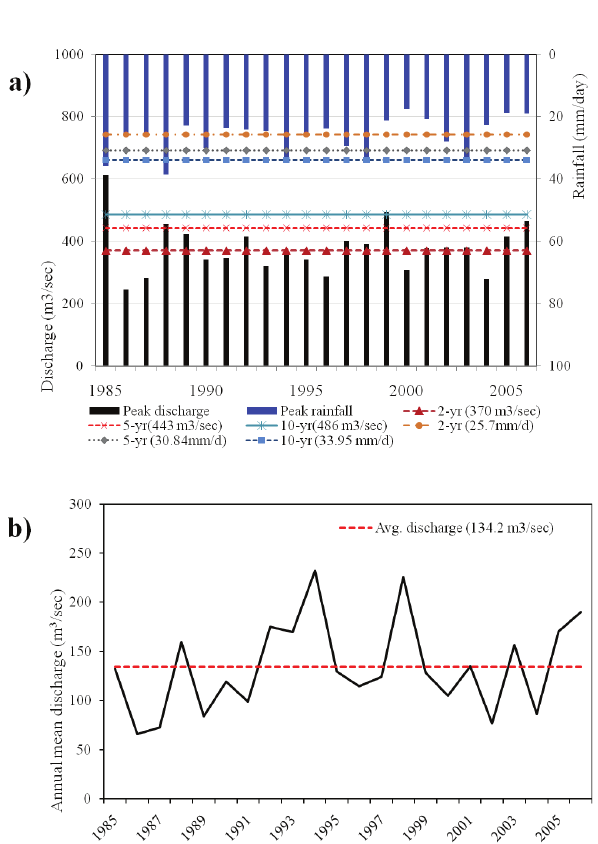
Fig. 4. Annual peak rainfall and discharge for 1985-2006 with (a) the 2-, 5- and 10-year return period (b) annual mean discharge.